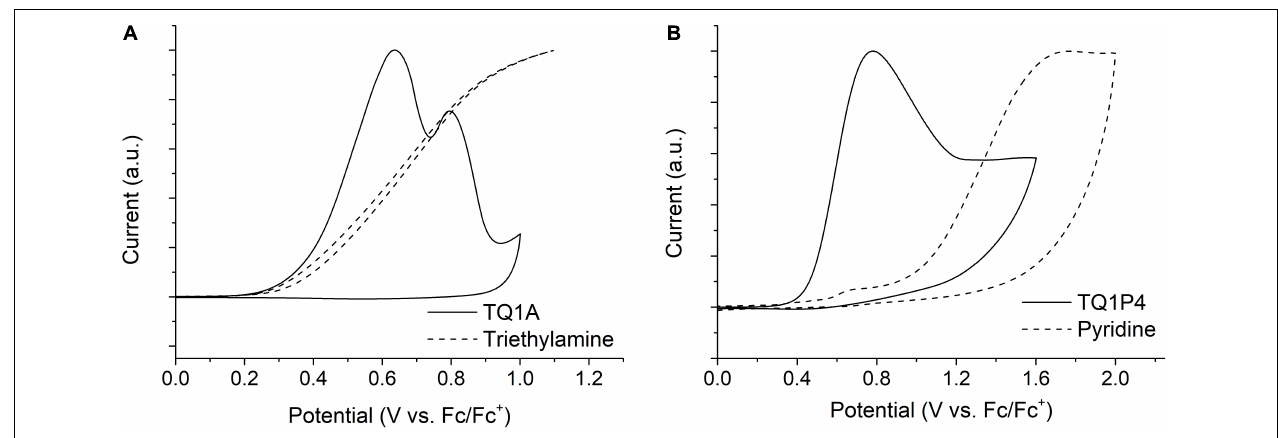
Frontiers in Materials |